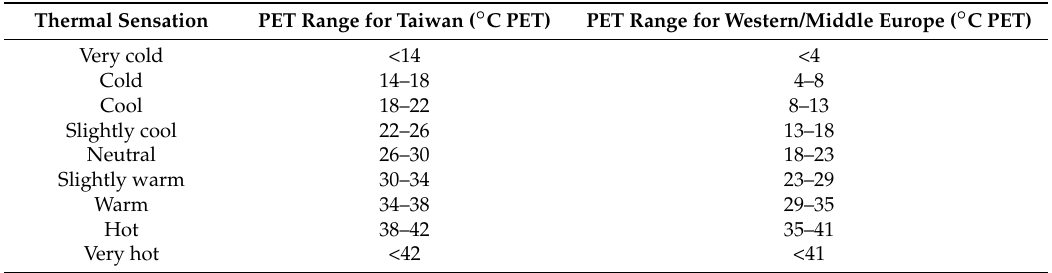
Table 1. Thermal sensation classification for Taiwan and western/middle